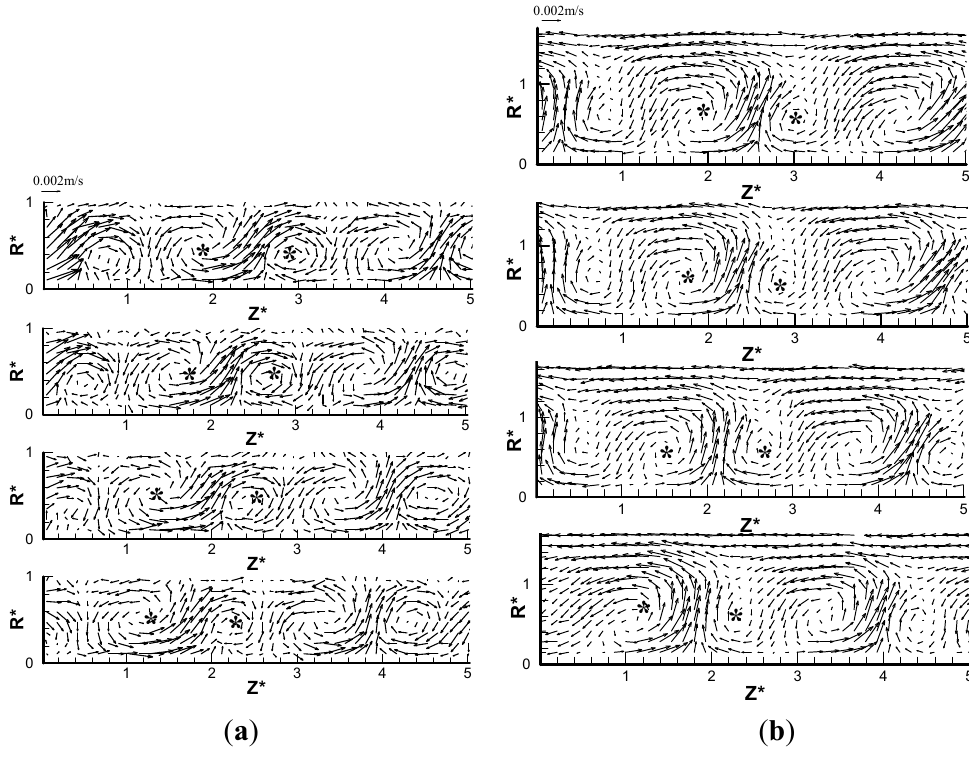
Figure 3. Instantaneous velocity fields of helical vortex flow: ( a ) Plain model; and ( b ) 9-slit model. The scale of the vector is 0.002 m/s. * means the center of the